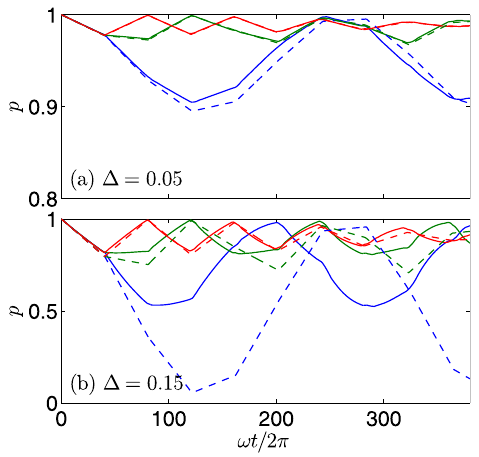
Figure 4 . (Color online) Probability of fi nding the particle in the initial state (the defect mode) against the number of driving cycles. The lattice size is N = 201 and the depth of the defect is U = 1. The amplitude of driving is shown in each panel. In each panel, the solid lines are exact results obtained by solving the time-dependent Schrödinger equation, while the dashed lines are based on (4) and (10). In each panel, at ω t /2 π = 100, from bottom to top, the solid lines correspond to 2 π / ω = 2.5, 2.51, 2.52, respectively. The same ordering holds for the dashed lines. Note that the distance between the kinks is independent of Δ .